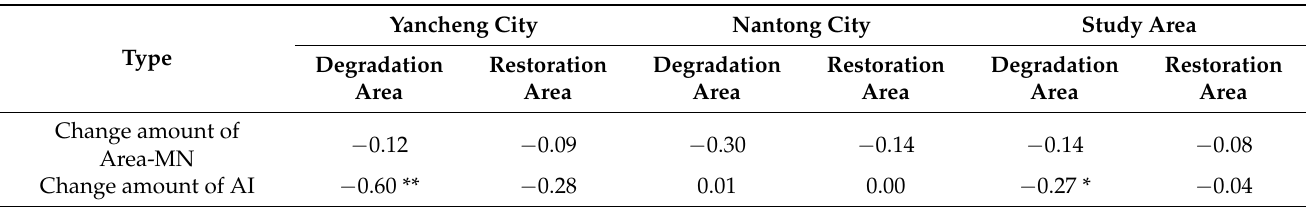
Table 6. Correlation coefficients between the landscape evolution area and change quantity of the landscape index. Mean patch area (Area-MN) and landscape aggregation index